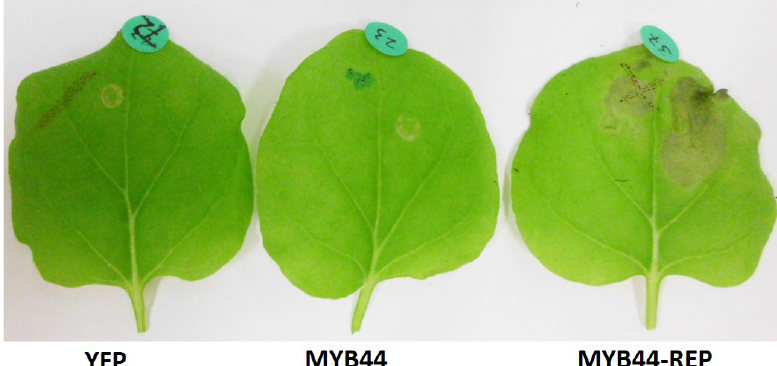
Figure 6. Overexpression of MYB44-REP causes necrotic lesions. N. benthamiana leaves were infiltrated with Agrobacteria carrying a construct for overexpression of YFP (control), MYB44 or MYB44-REP . The photo was taken eight days post-infiltration. All leaves shown are derived from the same plant. Consistent results were obtained from infiltration experiments with individual plants (1 plant/construct).